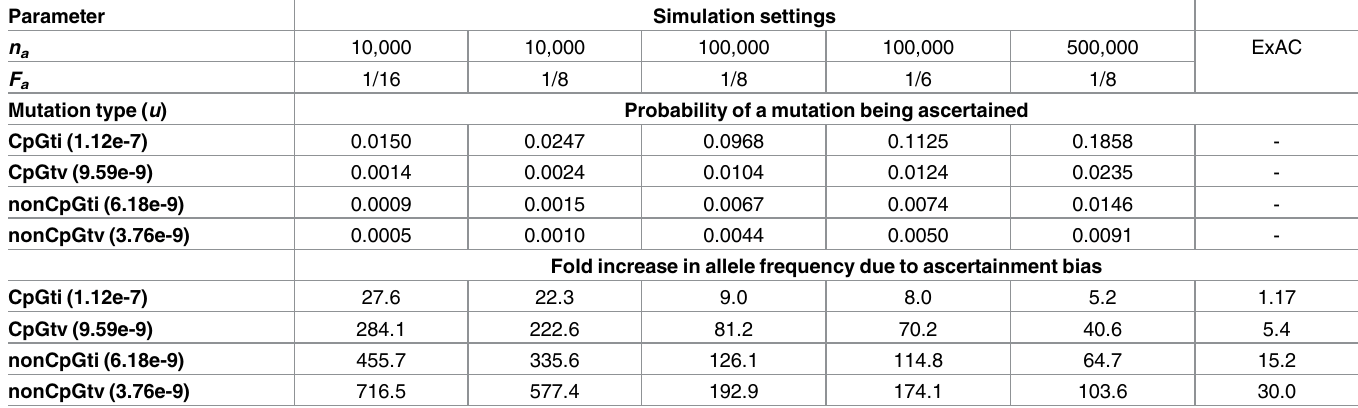
Table 1. For a given set of parameters n a (the sample size in a putative disease ascertainment study) and F a (the averageinbreeding coefficient of the population in which the study is being performed), we report the probability of a recessive, lethal mutation being ascertained, as well as the fold increase in mean allele frequencies of the ascertained cases ( q a ) in relation to the mean frequencies of all mutations for each mutation type ( q u ), based on simulations (see Methods for details). For a similar result derived from analyticalmodeling, see S6 Fig. Parameters for this step of the sim- ulation correspond to plausiblescenariosfor humanpopulationswith widespread inbreeding(e.g., F a = 1/16 correspondsto offspring of first-cousin marriage). The last column in the bottom panel shows the fold increaseof the mean allelefrequencyobservedin ExAC in relationto simulations based on the Tennessen et al. [25] demographicmodel (see Methods). Mutation rates u per bp, per generation were obtainedfrom a large human pedigreestudy